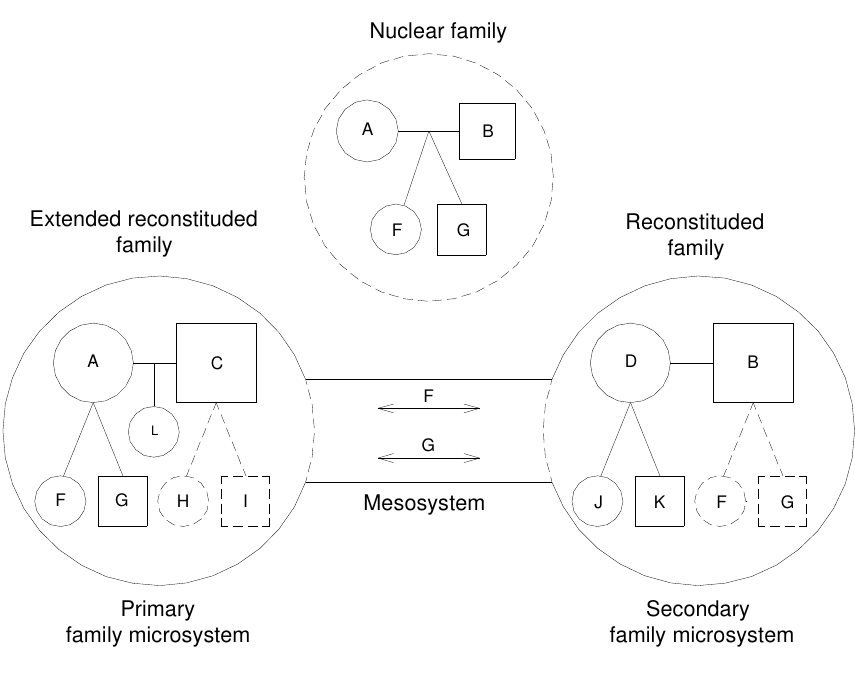
Figure 6 The primary and secondary family microsystems of the children of divorced Spouses A and B where both spouses remarried and Spouse A has an extended RF (Ebersohn,